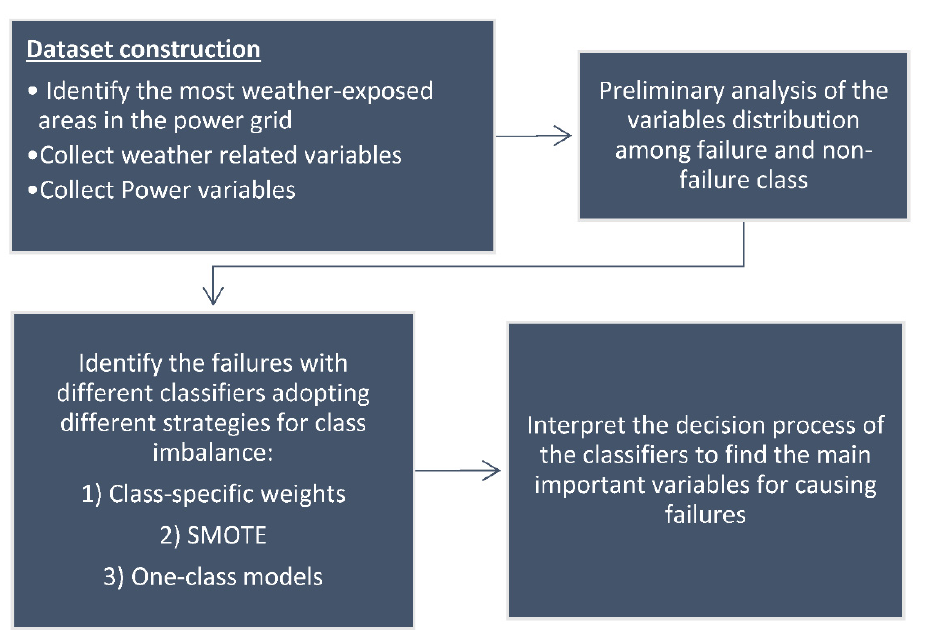
Figure 3. Flow chart of the proposed methodology. From step 1 to construct the dataset to the final step where the main important variables for causing failures are identified. step where the main important variables for causing failures are